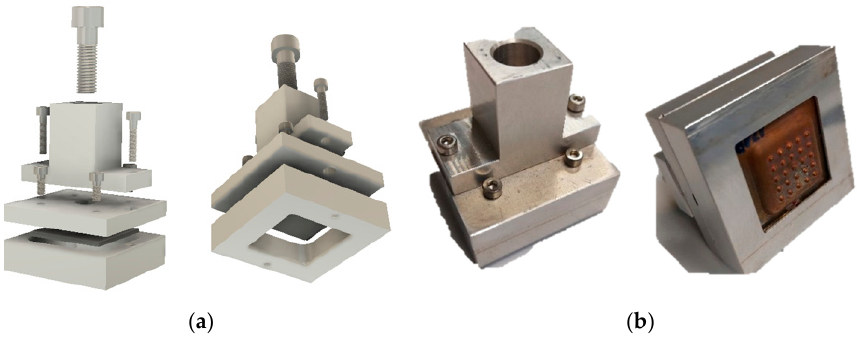
Figure 8. ( a ) Shell holder modelling. ( b ) Shell holder manufactured.